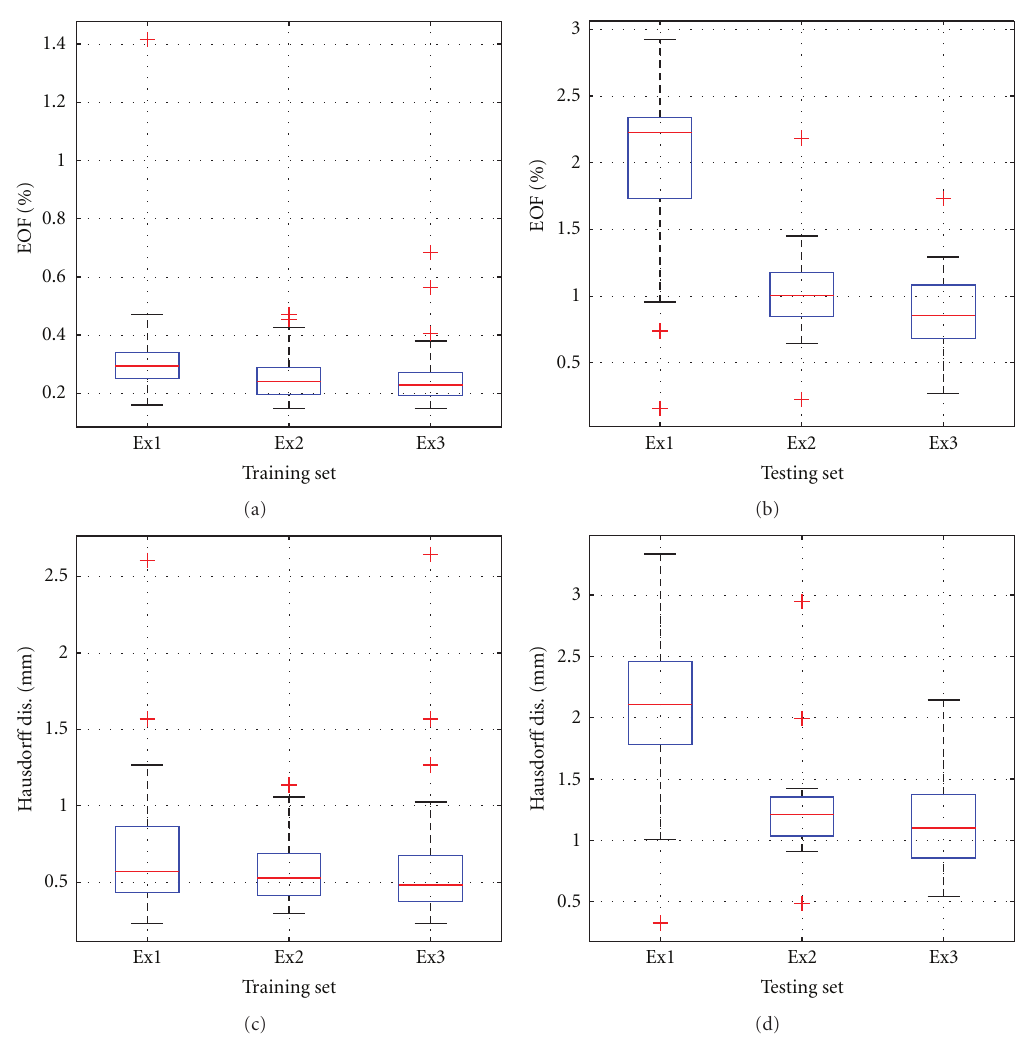
Figure 18: Boxplots of representation error in intermodel experiments: (a) EOF of training set, (b) EOF of testing set, (c) Hausdor ff distance of training set, (d) Hausdor ff distance of testing